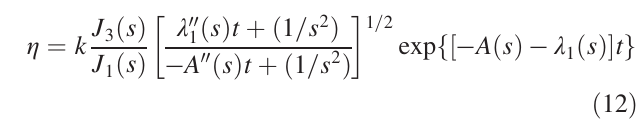
FIG. 5. Comparison of the total electric particle number N E ; E; t Þ and positron number N 0 e (cid:3) ð approximate solutions. In the calculation, the incident energy E 500 MeV and the lower bound energy E ¼ 50 MeV. The 0 ¼ blue curve shows the total number of positrons. The red symbol “ þ ” shows the half number of total particles and the red curve shows the 1st term of Eq. (11) which consist with each other. The black curve shows the 2nd term of Eq. (11) and tends to zero. The dash lines show the numerical percentage of positrons with different E 0 =E